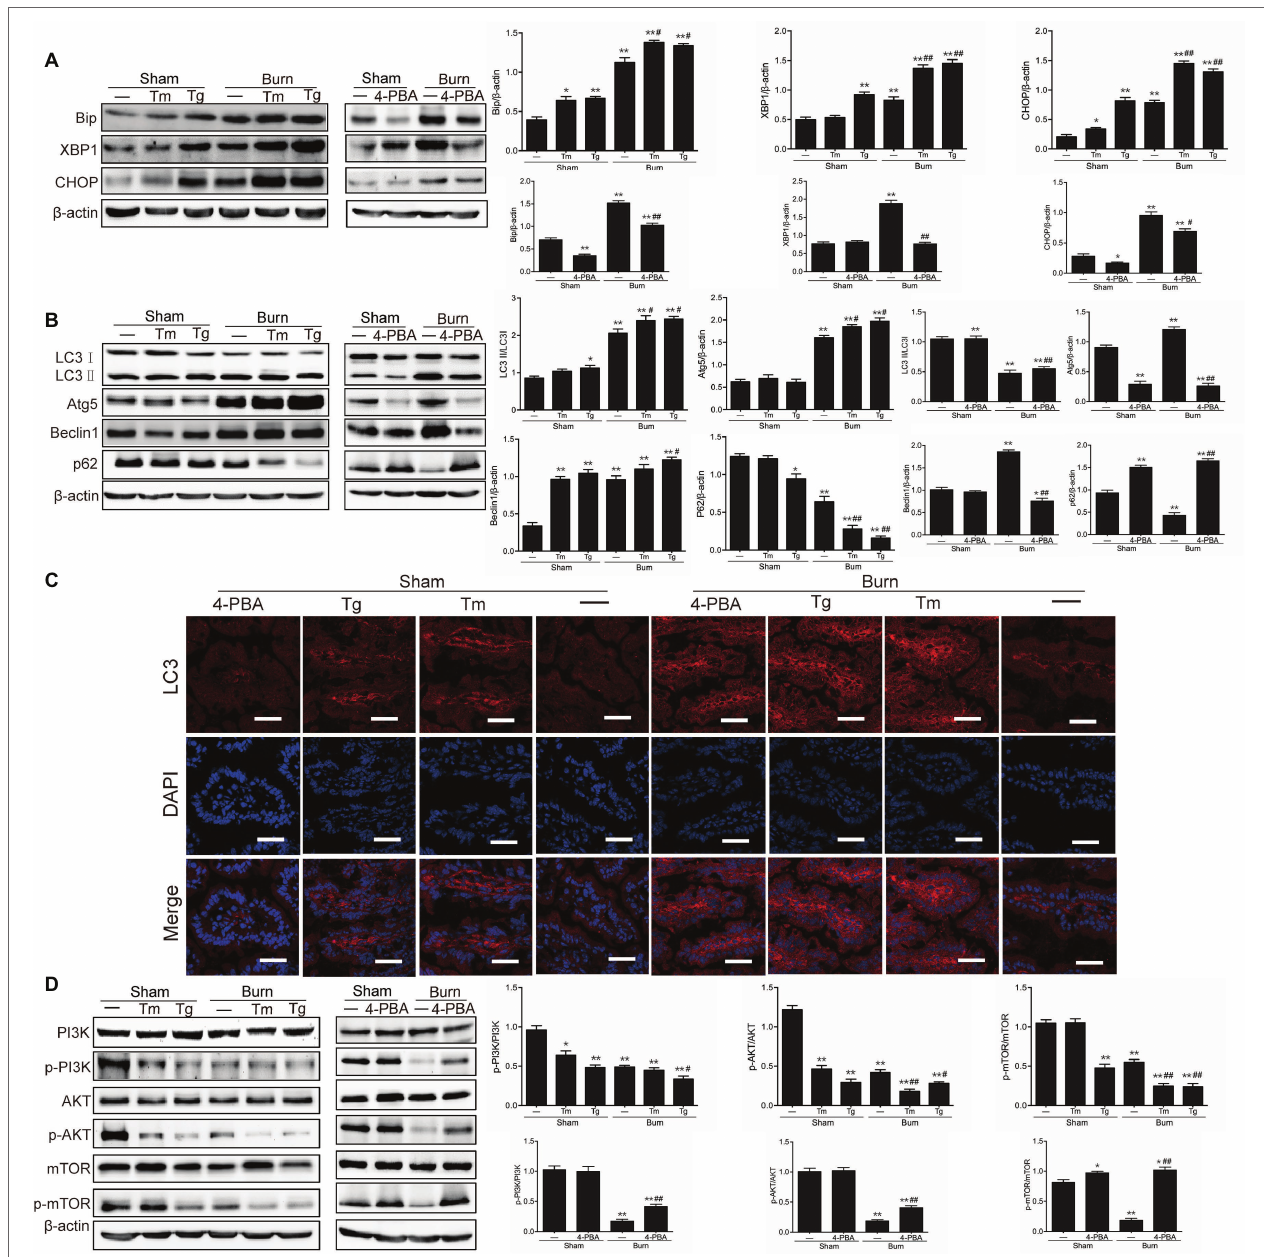
FIGURE 1 | Severe burn-induced endoplasmic reticulum (ER) stress triggers autophagy via inhibiting the PI3K/AKT/mTOR pathway. Mice were treated with or without tunicamycin (1.0 mg/kg), thapsigargin (300 ng/kg), and 4-PBA (80 mg/kg), respectively, for 1 h and then inflicted with the sham or 30% TBSA burn. (A) The ileal mucosa lysates were taken at 6 h after sham burn or burn injury and then analyzed for the expression of ER stress markers by immunoblot, with β -actin as loading control. Data represent mean ± SEM. * p < 0.05, ** p < 0.01, compared with sham-burn group ( n = 5). # p < 0.05, ## p < 0.01, compared with burn group ( n = 5). (B) The ileal mucosa lysates were analyzed for the expression of autophagy markers by immunoblot. Data represent mean ± SEM. * p < 0.05, ** p < 0.01, compared with sham-burn group ( n = 5). # p < 0.05, ## p < 0.01, compared with burn group ( n = 5). (C) LC3 was stained by immunofluorescence assay. Data are representative of five independent experiments. Scale bar = 20.0 μm. (D) The ileal mucosa lysates were analyzed for the expression of PI3K/AKT/mTOR pathway molecules by immunoblot. Data represent mean ± SEM. * p < 0.05, ** p < 0.01, compared with sham-burn group ( n = 5). # p < 0.05, ## p < 0.01, compared with burn group ( n =